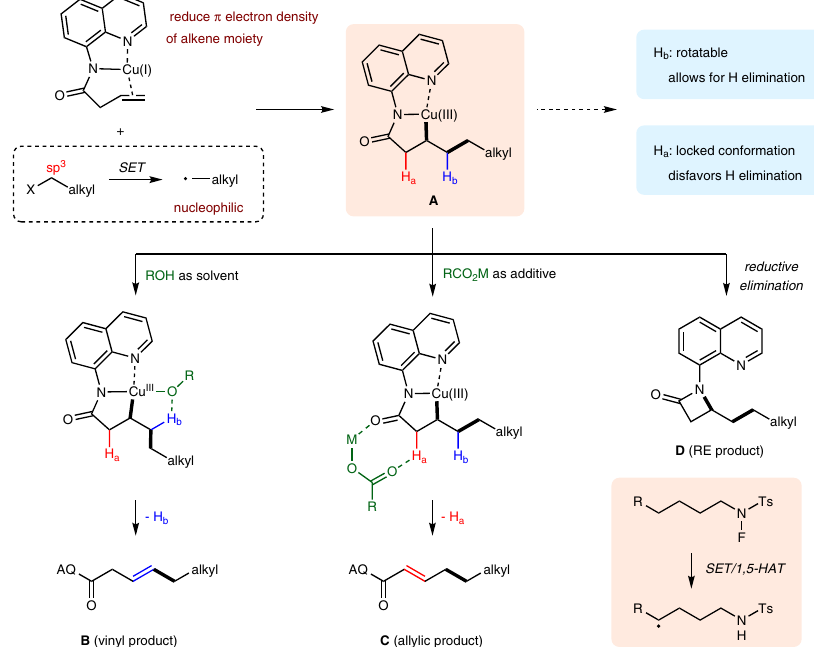
Fig. 2 | Divergent regioselective Heck-type reaction. External additives controlled divergent regioselectivities in intermolecular Heck-type reaction of unactivated alkenes and N - fl uoro-sulfonamides (this